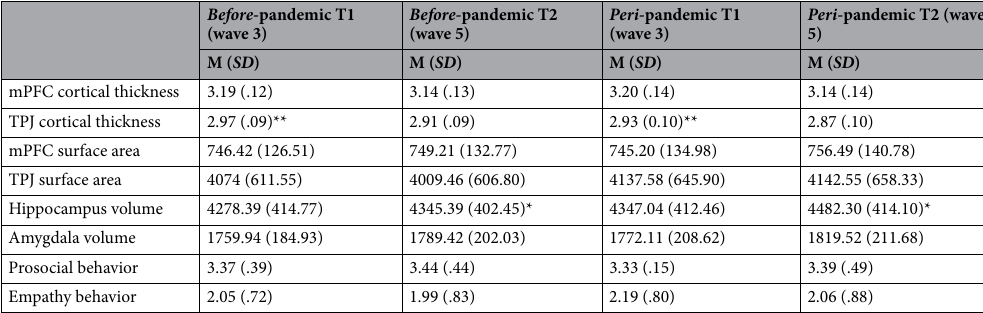
Table 2. Means and standard deviations of the dependent variables for each time point per group. M mean, SD standard deviation, mPFC medial prefrontal cortex, TPJ temporoparietal junction, Control analyses showed that TPJ cortical thickness differed between the before and peri pandemic group at time point 1. Hippocampus volume differed between the before and peri pandemic group at time point 2; *Significance of p < .05; **Significance of p <